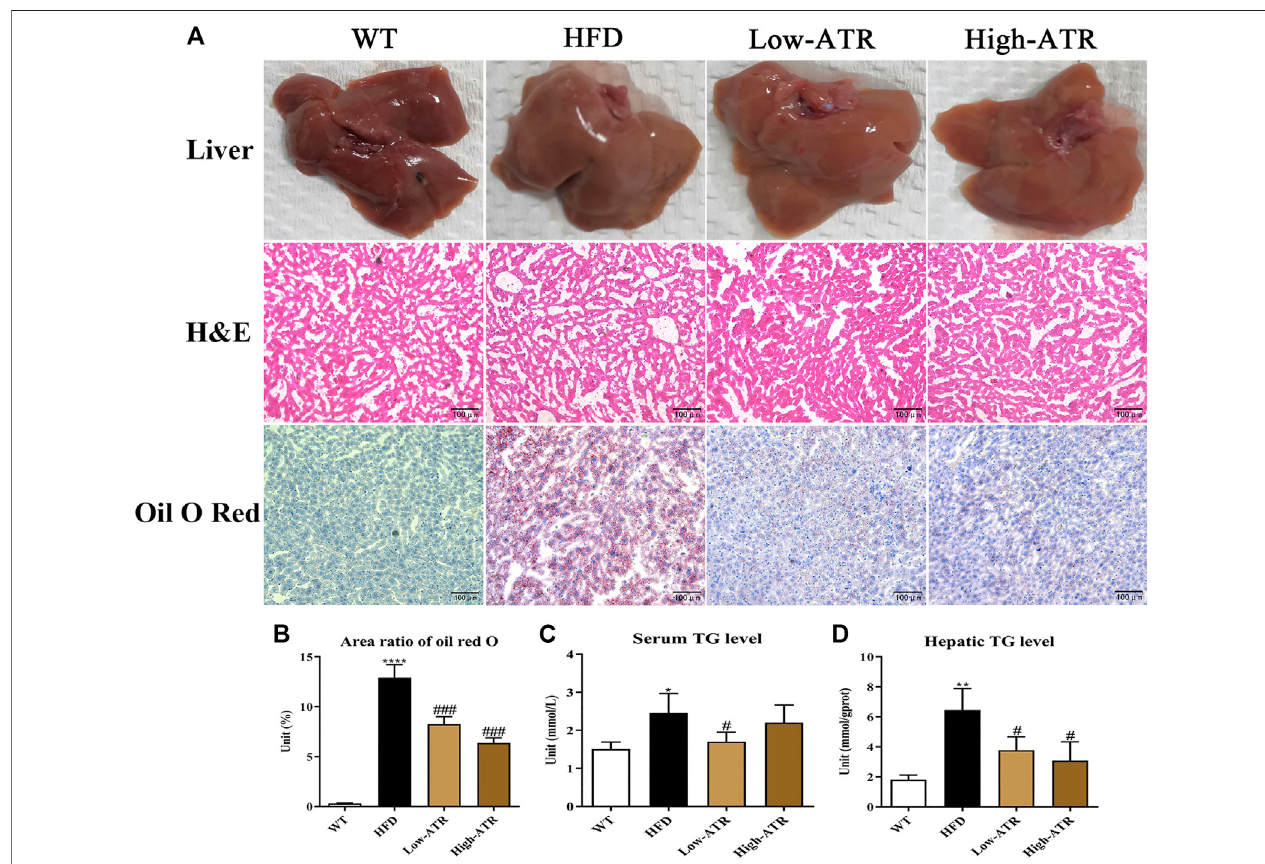
FIGURE2| Thechangesoflivermorphologyandhepaticlipidcontent. (A) Thefreshliversample,H&Estaining,andoilredOstainingofliver. (B) Arearatioofoilred O in the liver. (C) Serum TG (triglycerides) level. (D) Hepatic TG level. Data are expressed as mean ± SD ( n (cid:2) 8). * p < 0.05, ** p < 0.01, *** p < 0.001 (* represents HFD groupscompared withtheWTgroup). # p < 0.05, ## p < 0.01, ### p < 0.001( # representsATRtreatmentscompared withtheHFDgroup). WT (cid:2) controlgroup,andHFD (cid:2) high-fat diet